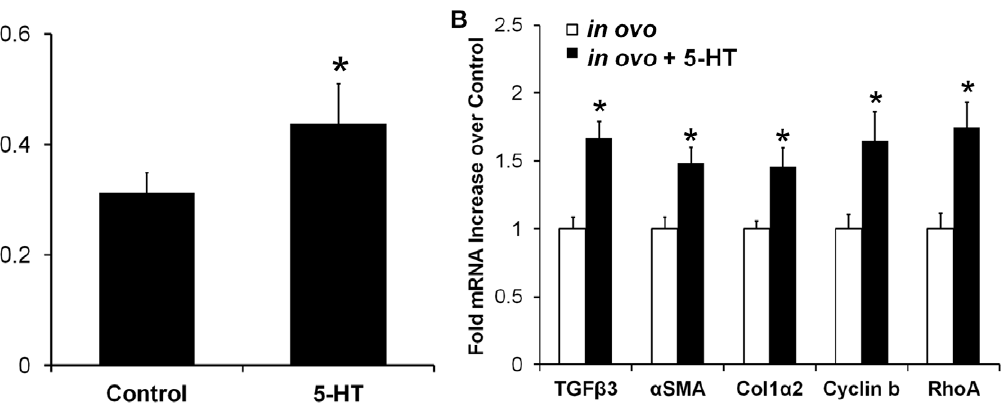
Figure 7. Exogenous 5-HT increases AV cushion stiffness and TGF b related remodeling genes inovo . A ) The strain energy density (Pa) of HH25 cushions increased 1.4 fold with systemic 5-HT treatment in ovo , mean 6 SEM, n=8–10 cushion, *p , 0.05, t-test. B ) Gene expression levels of HH25 AV cushions isolated from embryos treated with 5-HT at HH17 (48 hours). mean 6 SEM, n=6–10 samples, each of 8–10 pooled HH25 cushions, *p , 0.05, t-test. doi:10.1371/journal.pone.0042527.g007 dose (Figure 5). The physiological 5-HT concentration upregu-